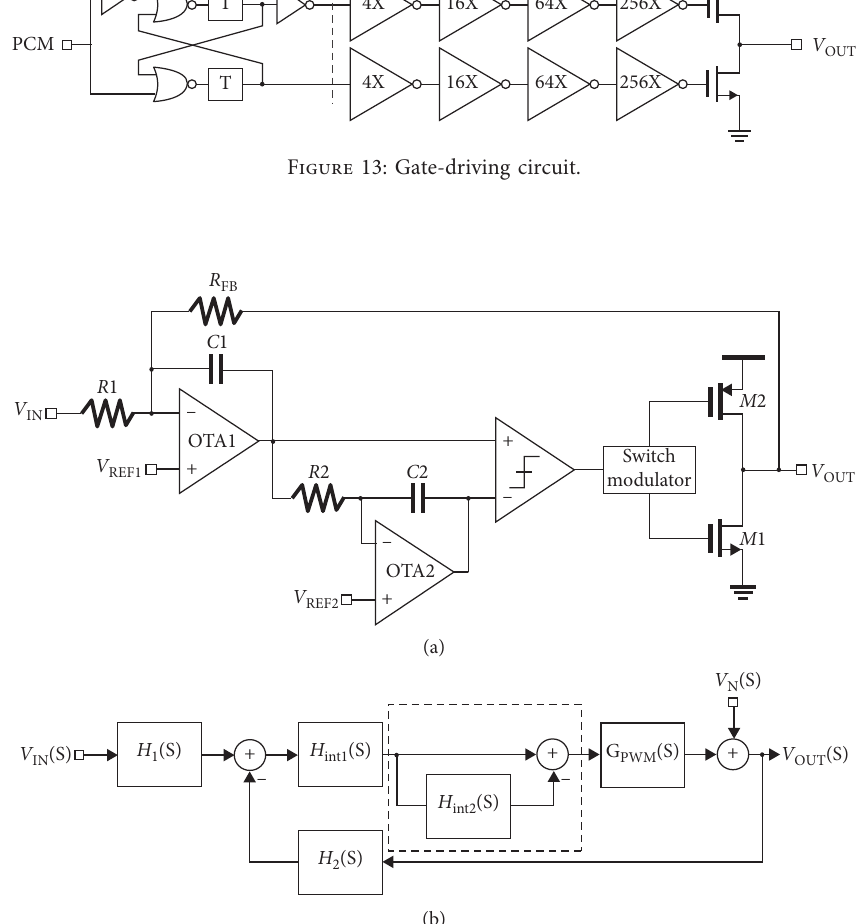
Figure 14: (a) Circuit diagram of the second-order closed-loop negative feedback. (b) Small-signal equivalent model.